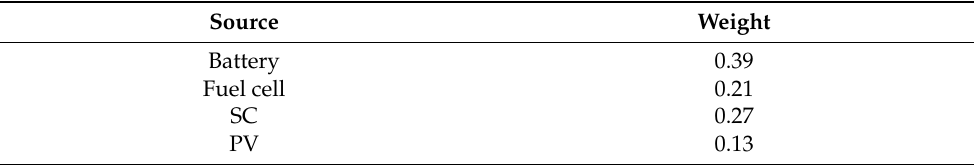
Table 7. Weights assigned to each of the sources.